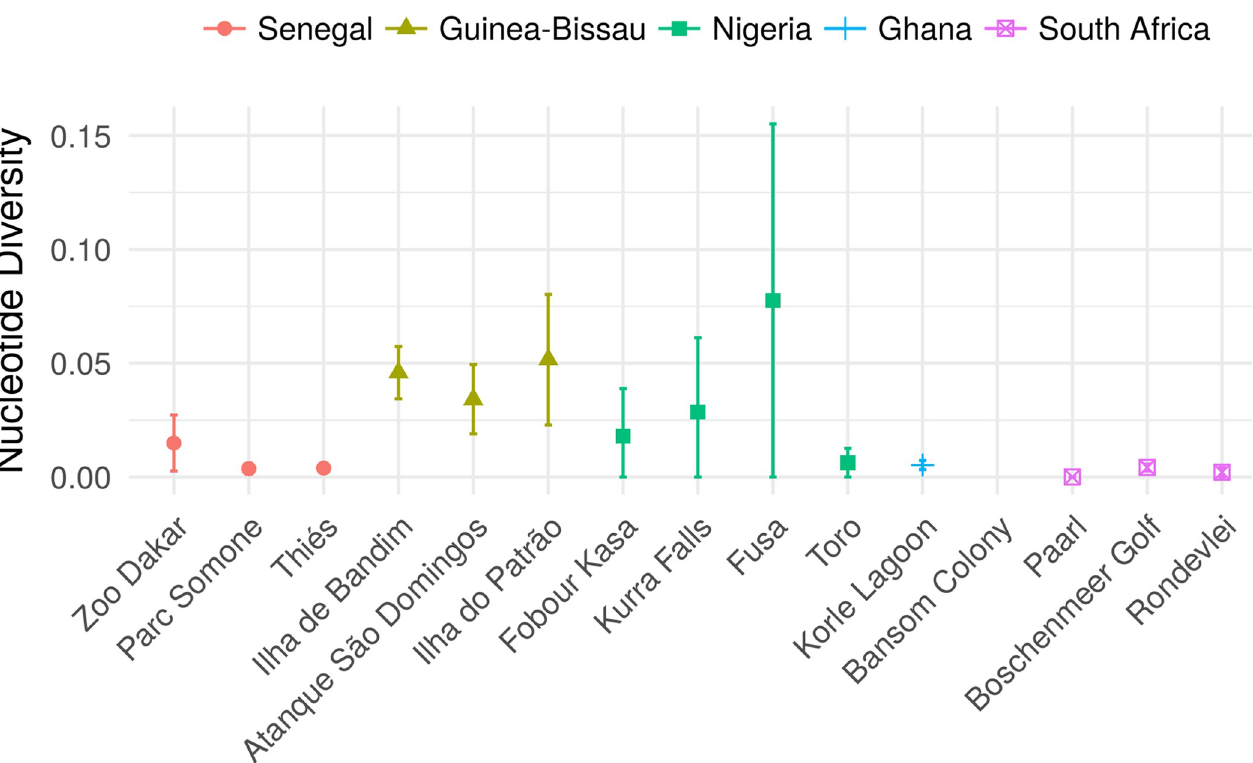
Fig 2. Spatial distribution of Plasmodium spp., nucleotide diversity, and relationships with environmental variables. Nucleotide diversity and variances of fifteen cattle egret colonies from five countries in central-western and southern regions of Africa.